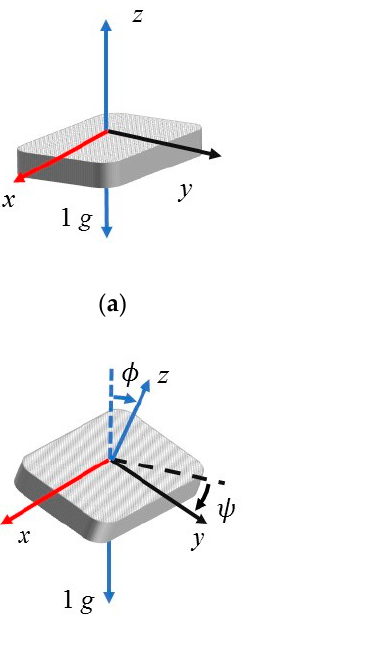
( b ) Figure 2. Sensing angles of the 1-axis and 2-axis MEMS accelerometer. ( a ) The 1-axis MEMS accelerometer; ( b ) the 2-axis MEMS accelerometer. 2.2. Single-Parameter Mathematical Model